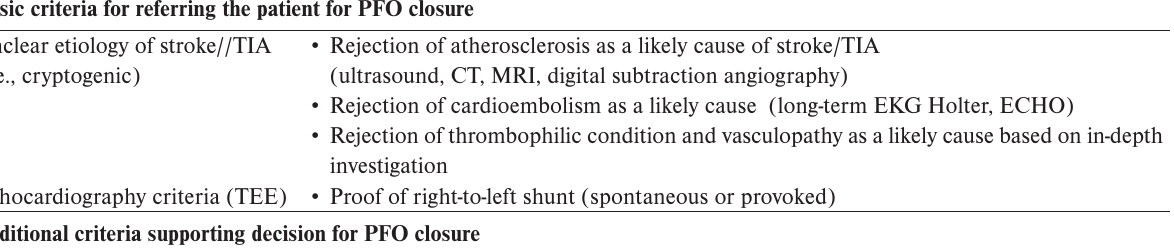
Echocardiography criteria (TEE) • Proof of right-to-left shunt (spontaneous or